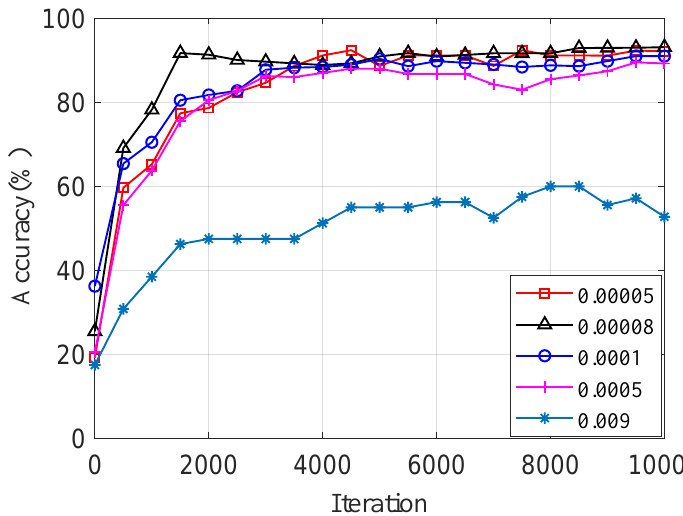
Figure 11. Accuracy under different learning rates.